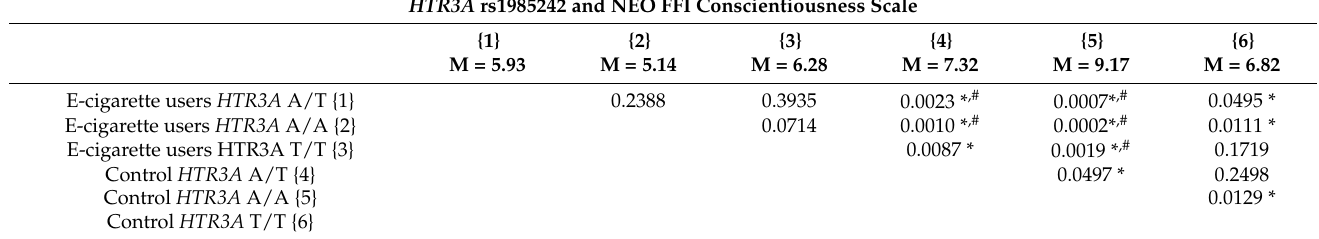
Table 6. Post hoc LSD (least significant difference) test of interactions between e-cigarette